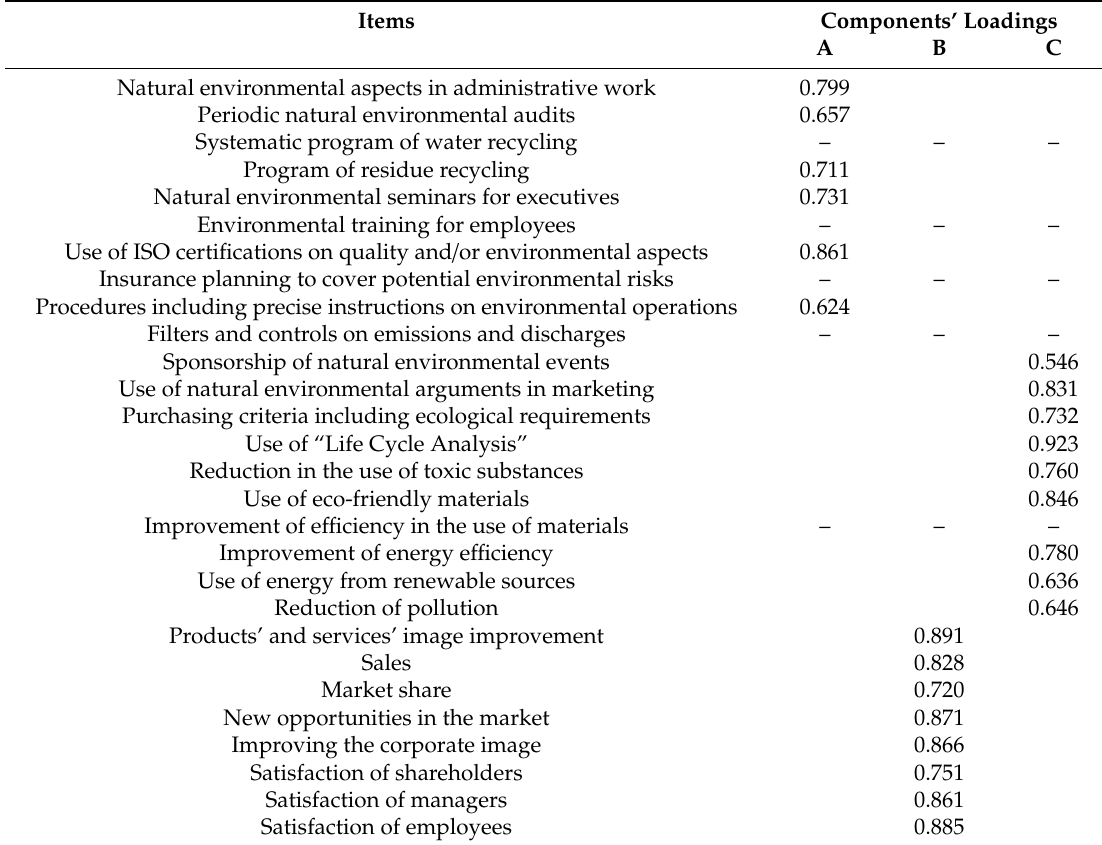
Table A1. Environmental process innovation, environmental product innovation and competitive advantage constructs’